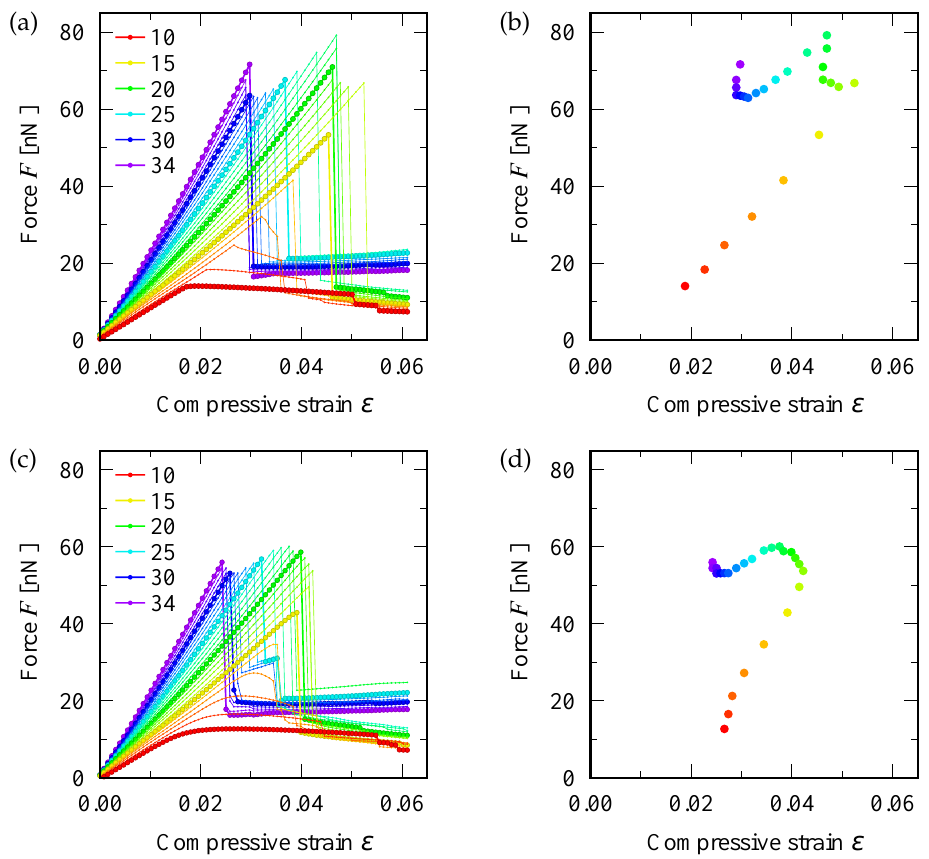
Figure 2. ( a , c ) The force-strain curve ( F vs. ε ) of zigzag SWNTs under axial compression, and ( b , d ) diagram of the critical buckling force F c and critical buckling strain ε c . The top (bottom) panels correspond to pristine (defective) SWNTs. The difference in the color of data points represents the value of the chiral index n shown in the legend of the panels ( a , c ); i.e., the red ( n = 10) and purple ( n = 34) lines are corresponding to the thinnest and thickest SWNTs,